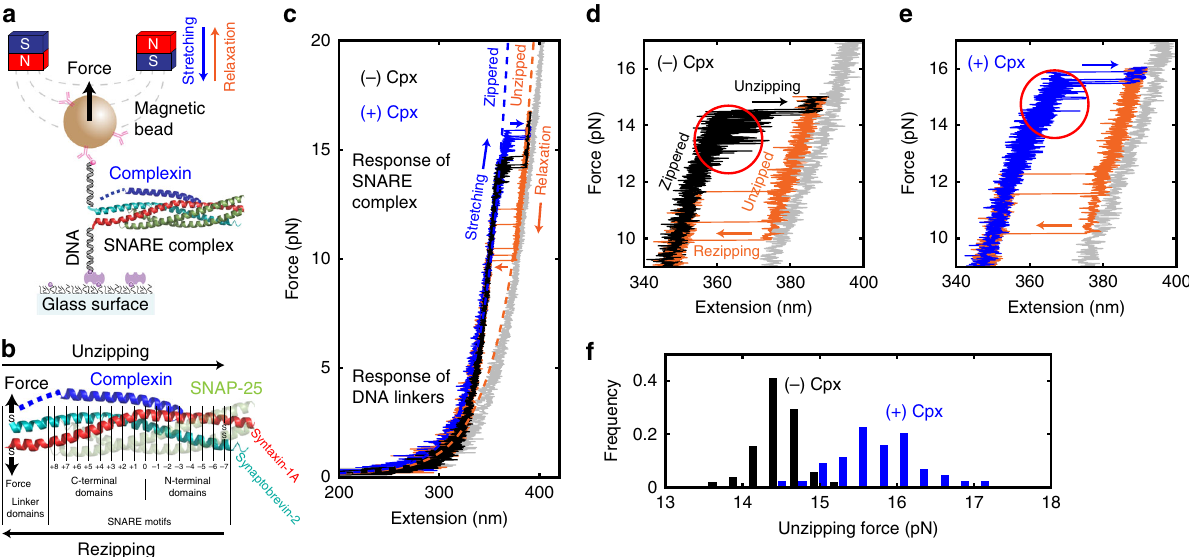
Fig. 1 Mechanical stabilization of SNARE complexes by complexin. a SNARE – DNA hybrid construct in magnetic tweezers setup. b A predicted three- dimensional structure of the neuronal SNARE complex bound to a molecule of Cpx (PDB 3IPD 49 aligned to 1KIL 20 ). The N-terminal domain of Cpx not determined in the crystal structure (1 – 25) is represented with a blue dashed line. The letters “ S ” denote the thiol groups of arti fi cial cysteine residues. The numbers below the structure indicate the leucine-zipper layers. c Typical force – extension curves from a single SNARE complex in the absence (black) and presence (blue) of Cpx. The black and blue traces show the stretching period that features “ unzipping ” events from the fully zippered to the unzipped state, while the orange traces show the relaxation period with the opposite “ rezipping ” events. In gray, a curve for the unfolded SNAREs that fail to re-zip is shown. Dashed lines indicate the models of extension for the corresponding conformations of SNARE complex (Supplementary Note 3). d , e Force – extension curves from a single SNARE complex in the absence ( d ) or presence ( e , same graph as in c ) of Cpx. f Unzipping force distributions from a single SNARE complex in the absence (black, N = 51) and presence (blue, N = 44) of 5 μ M